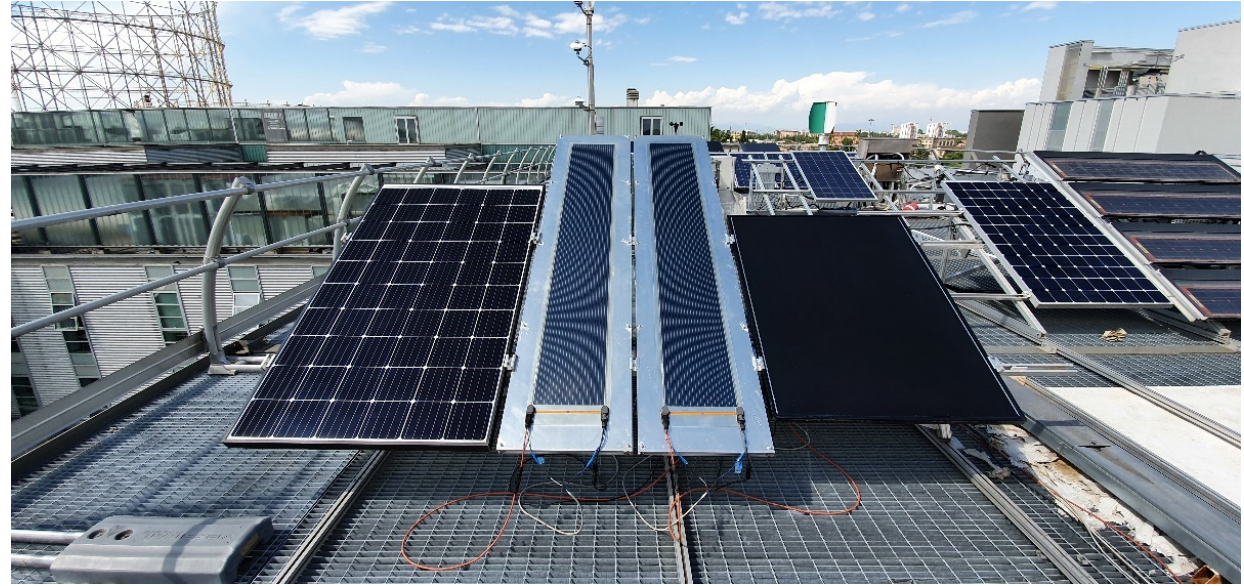
Figure 2. PV modules for comparative analysis among PV technologies. From left to the right: monocrystalline silicon, OPVs, and CIS.